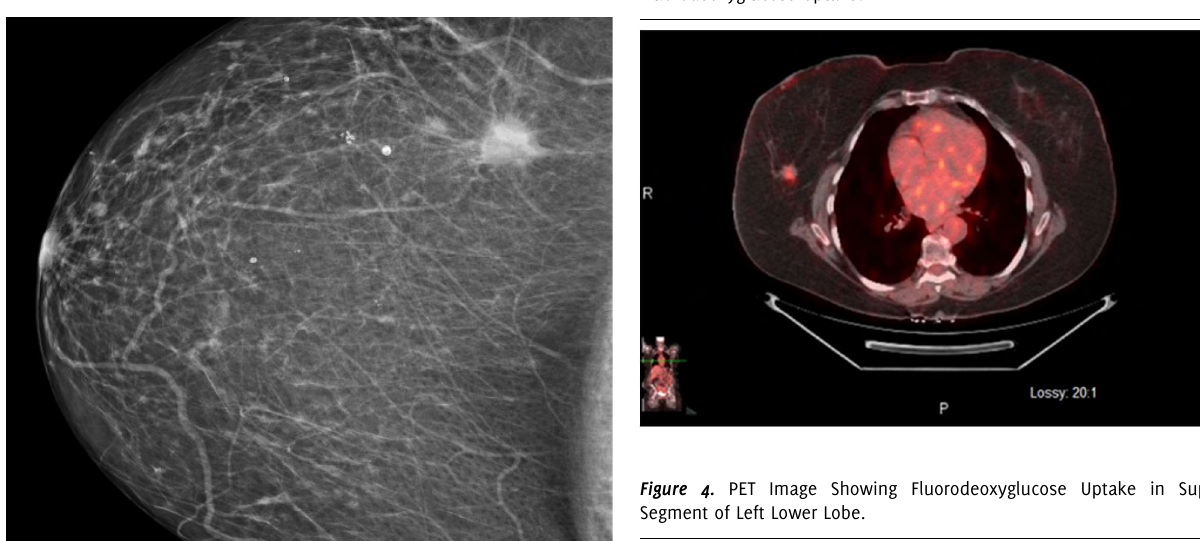
Figure 1. Screening Mammogram Showing Spiculated Mass in Right Breast.